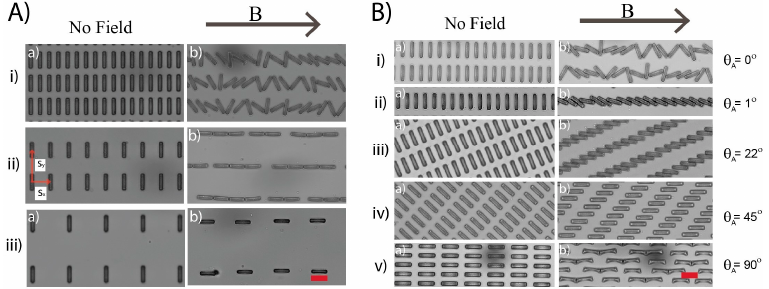
Figure 2. ( A ) Bright-field micrographs of cuboids (5 µ m × 20 µ m) in starting patterns (a) with array pitches s x and s y of 13 and 32 µ m (i), 26 and 44 µ m (ii), and 32 and 64 µ m (iii). On application of a 5 mT homogeneous field (b) the cuboids assemble into disordered linear chains (i), regular linear